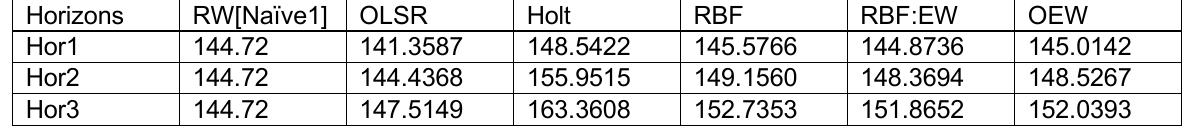
Table 3 : Forecast Values for the CMI Illustrative Dataset